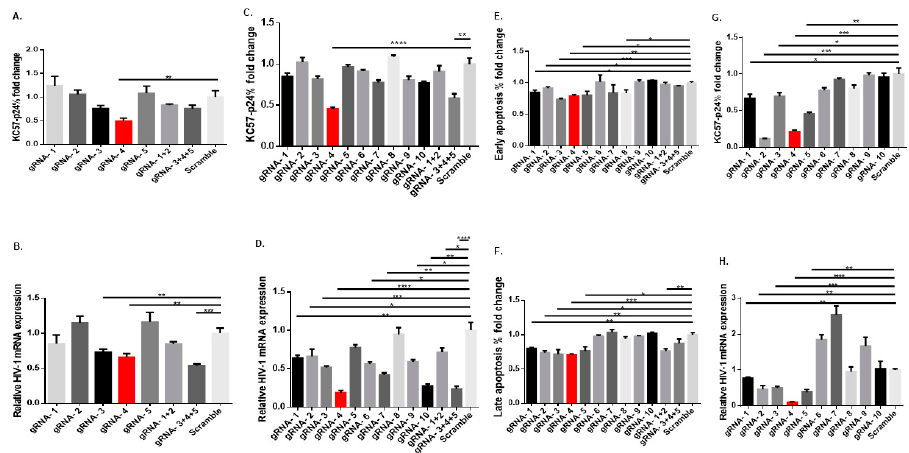
Figure 2. Treatment with gRNA/Cas9 RNPs reduces HIV-1 reactivation and apoptosis in J1.1 and U1 cells. ( A ) HIV p24 expression in J1.1 cells transfected with various gRNA/Cas9 RNPs for 48 h, normalized to the scramble control. ** p < 0.01. ( B ) Relative HIV mRNA levels in J1.1 cells transfected with various gRNA/Cas9 RNPs for 48 h, normalized to GAPDH, and then, the scramble control. ** p < 0.01, *** p < 0.001. ( C ) HIV p24 expression in J1.1 cells activated with anti-CD3/CD28 antibodies and transfected with various gRNA/Cas9 RNPs for 48 h, normalized to the scramble control. ** p < 0.01, **** p < 0.0001. ( D ) Relative HIV mRNA expression in J1.1 cells activated with anti-CD3/CD28 antibodies and transfected with various gRNA/Cas9 RNPs for 48 h, normalized to GAPDH, and then, the scramble control. * p < 0.05, ** p < 0.01, *** p < 0.001, *** p < 0.001. ( E , F ). Early (Av + 7AAD − ) and late (Av + 7AAD + ) apoptosis in J1.1 cells activated with anti-CD3/CD28 antibodies and transfected with various gRNA/Cas9 RNPs 48 h, normalized to the scramble control. * p < 0.05, ** p < 0.01, *** p < 0.001. ( G ) HIV p24 expression in U1 monocytes transfected with various gRNA/Cas9 RNPs for 48 h, normalized to the scramble control. * p < 0.05, ** p < 0.01, *** p < 0.001. ( H ) Relative HIV mRNA levels in U1 monocytes transfected with various gRNA/Cas9 RNPs for 48 h, normalized to GAPDH, and then, the scramble control. ** p < 0.01, *** p < 0.001, **** p < 0.0001. T cell receptor (TCR) activation can promote transfection efficiency (Supplemental